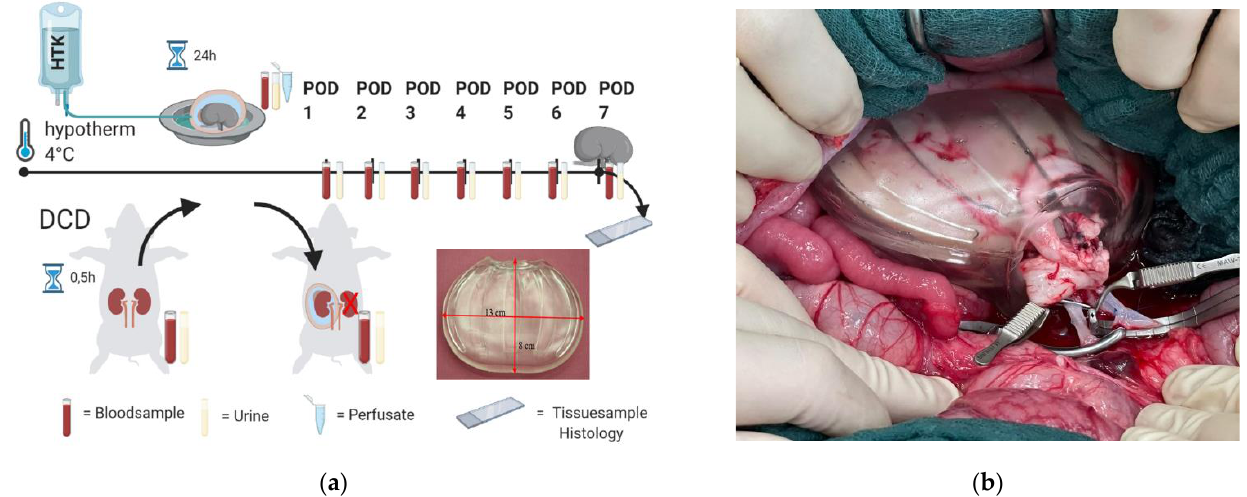
Figure 8. ( a ) Overview of the study design of the in vivo experiment. Schematic illustration was created with BioRender.com TIB prototype used as the test product as a high elastic, bag-shaped device for organ protection and thermal insulation ( b ) TIB placed in situ during